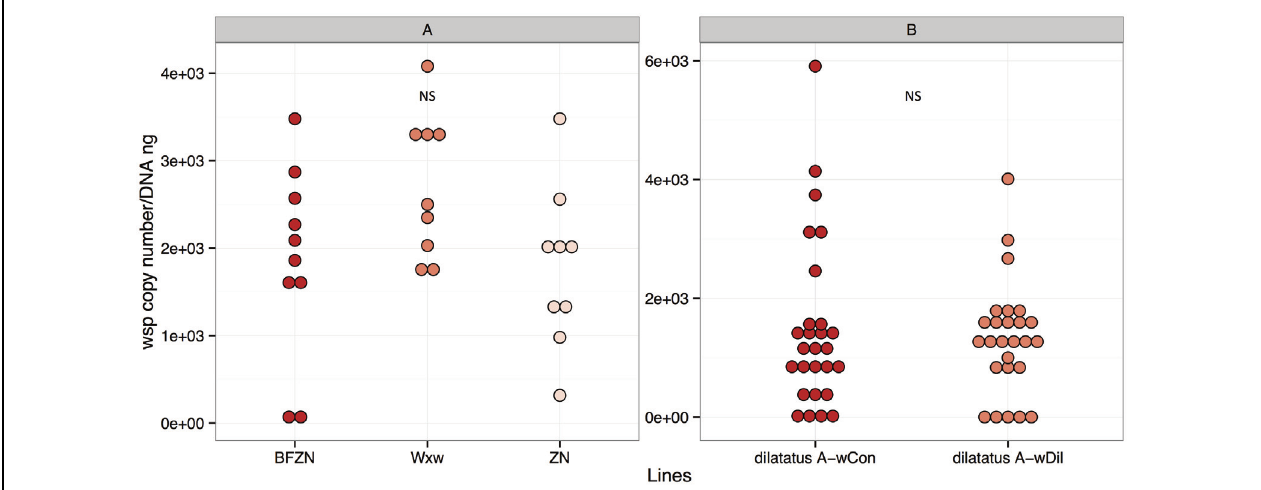
FIGURE 1 | Wolbachia density in Armadillidium vulgare (A) and Porcellio dilatatus (B). The qPCR quantifications of wsp copy number/DNA ng in BF w VulC, ZN and WX w lineages and dilatatus A- w Con, dilatatus A- w Dil lineages were made, using leg and ovary samples respectively. NS, not significant. TABLE 2 | Survival analyses of the different A. vulgare and P. dilatatus lines when injected with S. typhimurium or L. ivanovii .